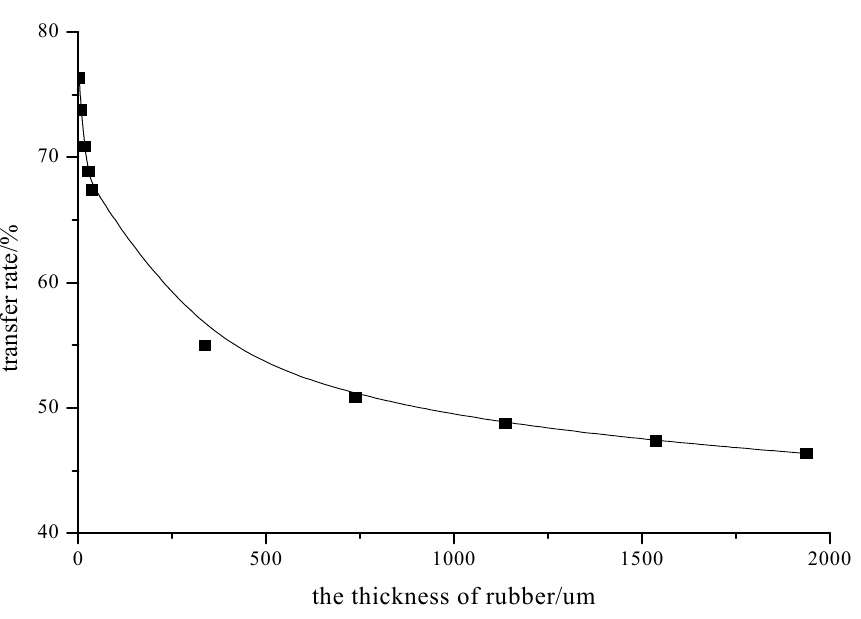
Figure 6. Interlayer thickness vs. strain transfer rate of a clamped FBG sensor.